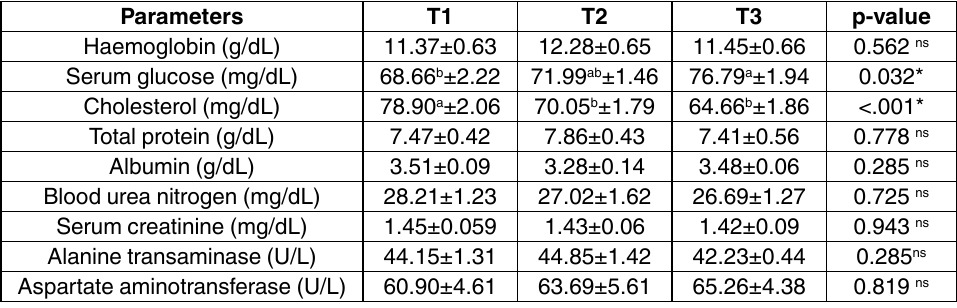
table 1. Haematological and serum biochemical parameters 1 of buffalo heifers maintained on three experimental